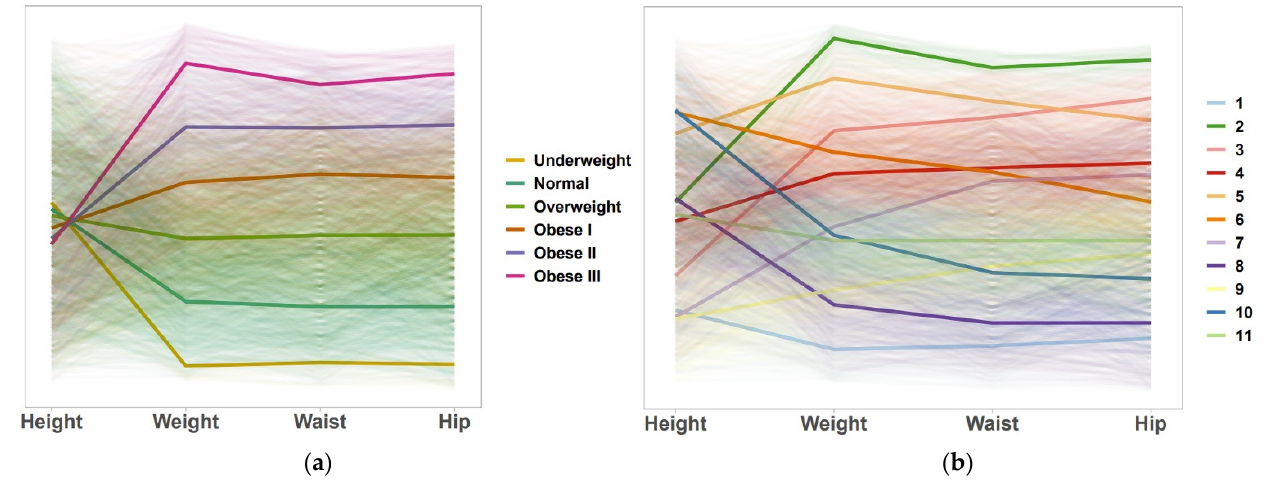
Figure 1. Parallel coordinates plot for categories of BMI and AGI-11 under the four anthropometric measurements (height, weight, waist circumference, hip circumference): ( a ) BMI; ( b ) AGI-11.